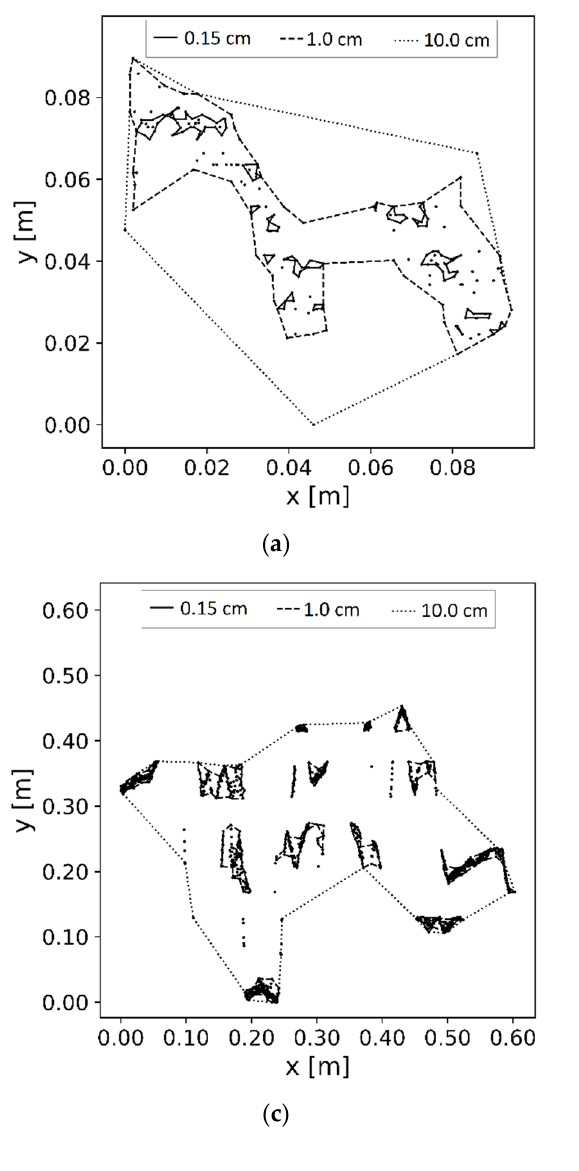
Figure 3. Estimated areas from single point cloud slices with 0.1 cm height for different size classes of strawberry plants using different D max (0.15 cm, 1.0 cm, and 10.0 cm): ( a ) juvenile-1, ( b ) juvenile-2, ( c ) mature-1, and ( d ) mature-2.